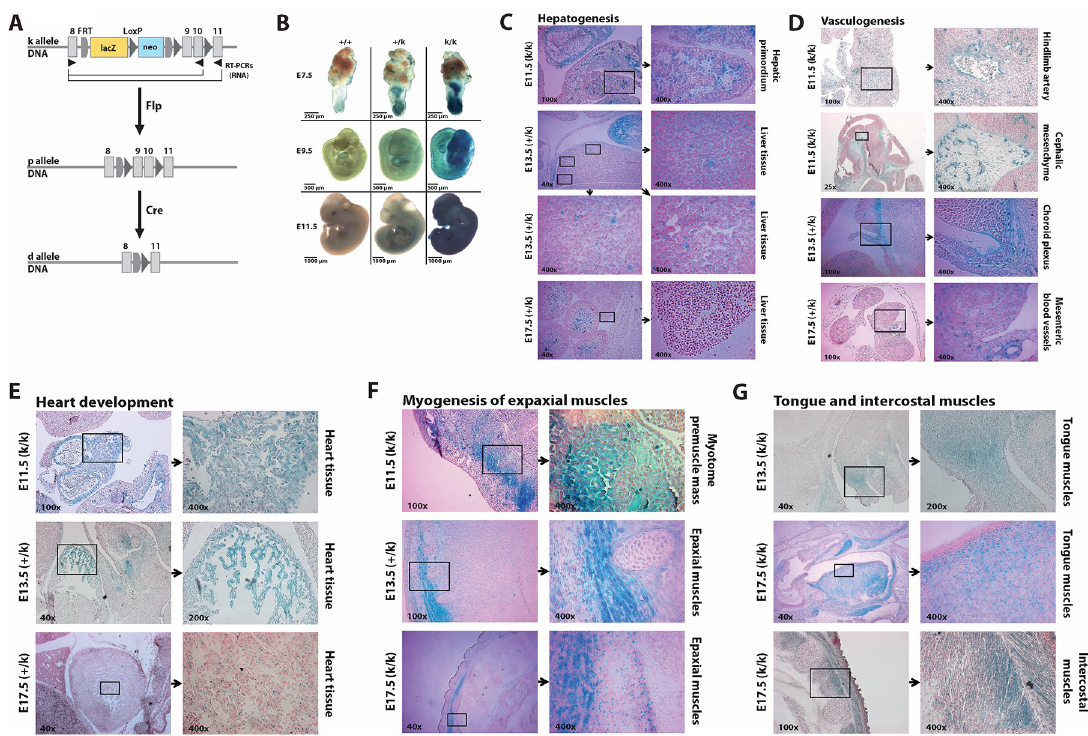
Fig 1. Expression sites of Jmjd1c during embryonic development. (A) Schematics of the Jmjd1c allele status. Knockout first mice ( Jmjd1c -k allele) were crossed with FLPe mice to create conditional knockout mice ( Jmjd1c -p allele). Further matings with Cre deleter mice were performed to excise exons 9 and 10 ( Jmjd1c -d allele). Numeration of exons is shown in S1 Fig. (B) Beta-galactosidase staining of whole-mount mouse embryos at day E7.5, E9.5 and E11.5 of embryonic development. Scale bars: E7.5 = 250 μ m, E9.5 = 500 μ m, E11.5 = 1000 μ m. (C-G) Sections showing beta-galactosidase signals during hepatogenesis (C) , vasculogenesis (D) , heart development (E) and myogenesis of skeletal muscles (F+G) . E11.5 and E13.5 whole mouse embryos were beta-galactosidase stained with